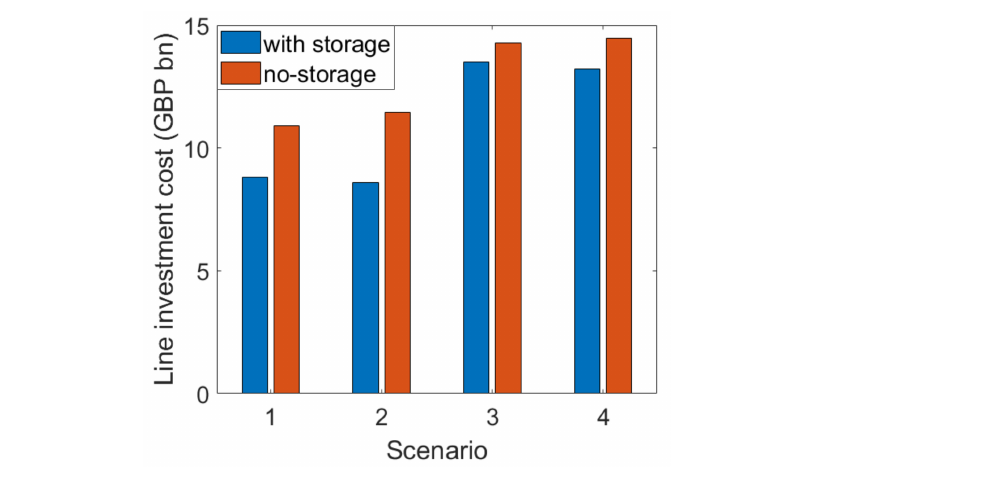
Figure 20. Optimal accumulated line investment cost per scenario for the stochastic studies with and without storage.